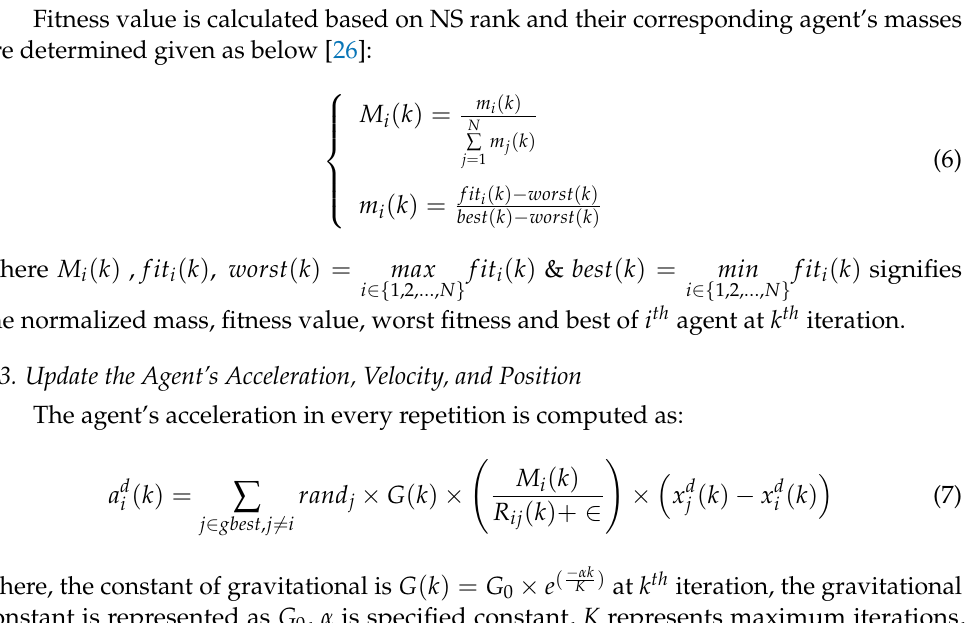
Figure 1. Relationship between the non-domination rank and fitness.